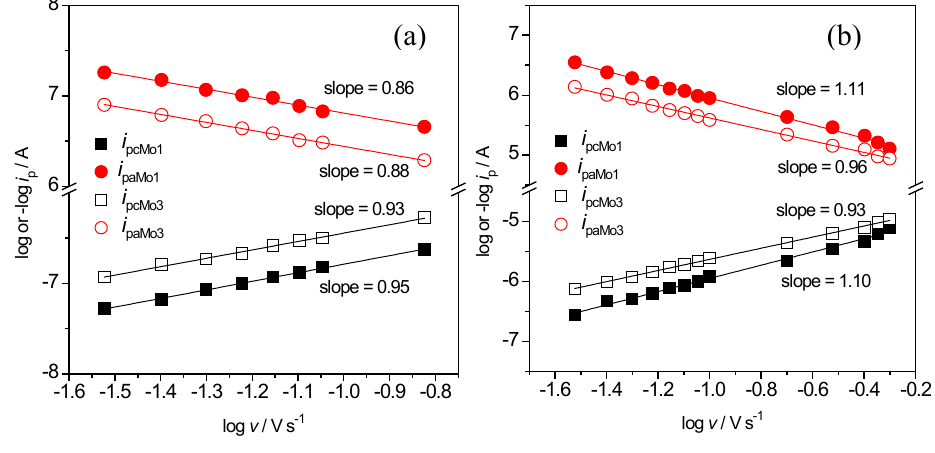
Figure 3. Plots of log i pc and i pa vs. log ν of PMo 11 V ( a ) and PMo 11 V@N-FLG ( b